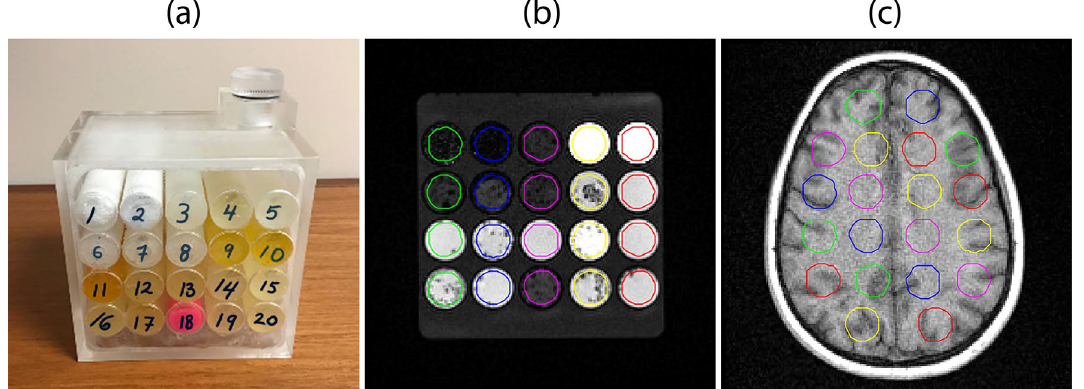
Figure 4. The MRI phantom and the healthy volunteer’s brain ( a ) The MRI phantom consisting of 20 different materials. ( b ) A T1-weighted image of the phantom. ( c ) A T1-weighted image of the healthy volunteer’s brain with 20 ROIs.